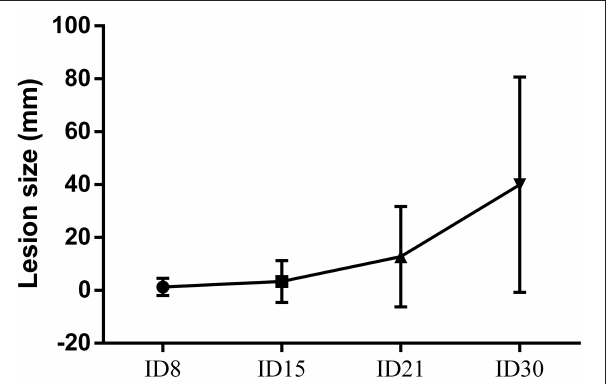
FIGURE 1 | Cutaneous leishmaniasis progression . Quantification of lesion area in in golden hamsters experimentally infected with 5 × 10 8 promastigotes of L. (V) braziliensis . Data are presented as the mean ± SD of 24 hamsters at days 8, 15, 21, and 30 after infection.